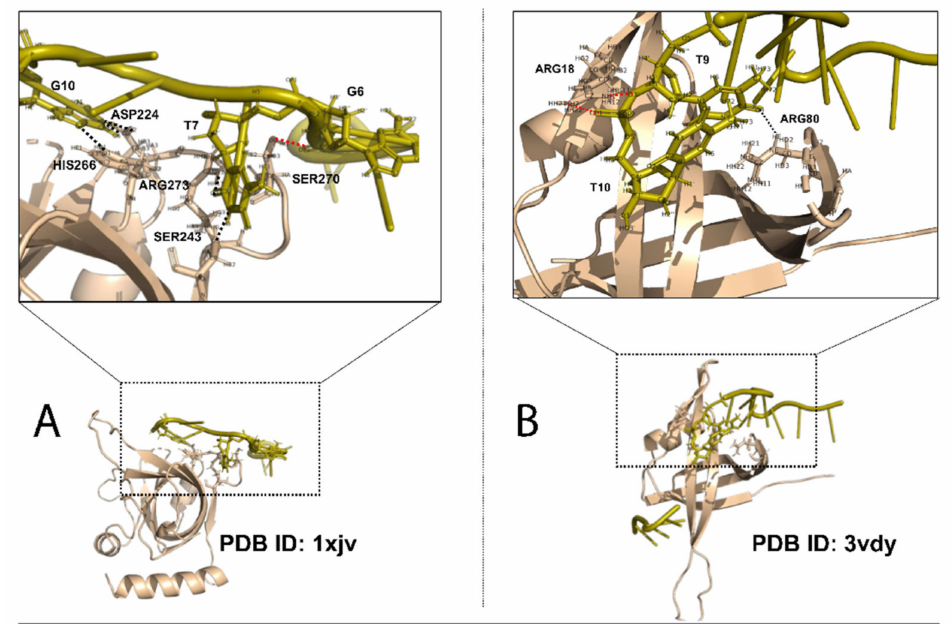
Figure 1. OB fold of SSBs and binding specificity. ( A ) Specific OB fold domain of human POT1 bound to telomeric single-stranded DNA (TTAGGGTTAG), PDB ID: 1xjv, chain: A, domain: 151–299. ( B ) Non-specific OB fold of Bacillus subtilis SsbB, PDB ID: 3vdy, chain: A. Black dashed lines, sidechain- base hydrogen bonds; red dashed lines, non-sidechain-base hydrogen